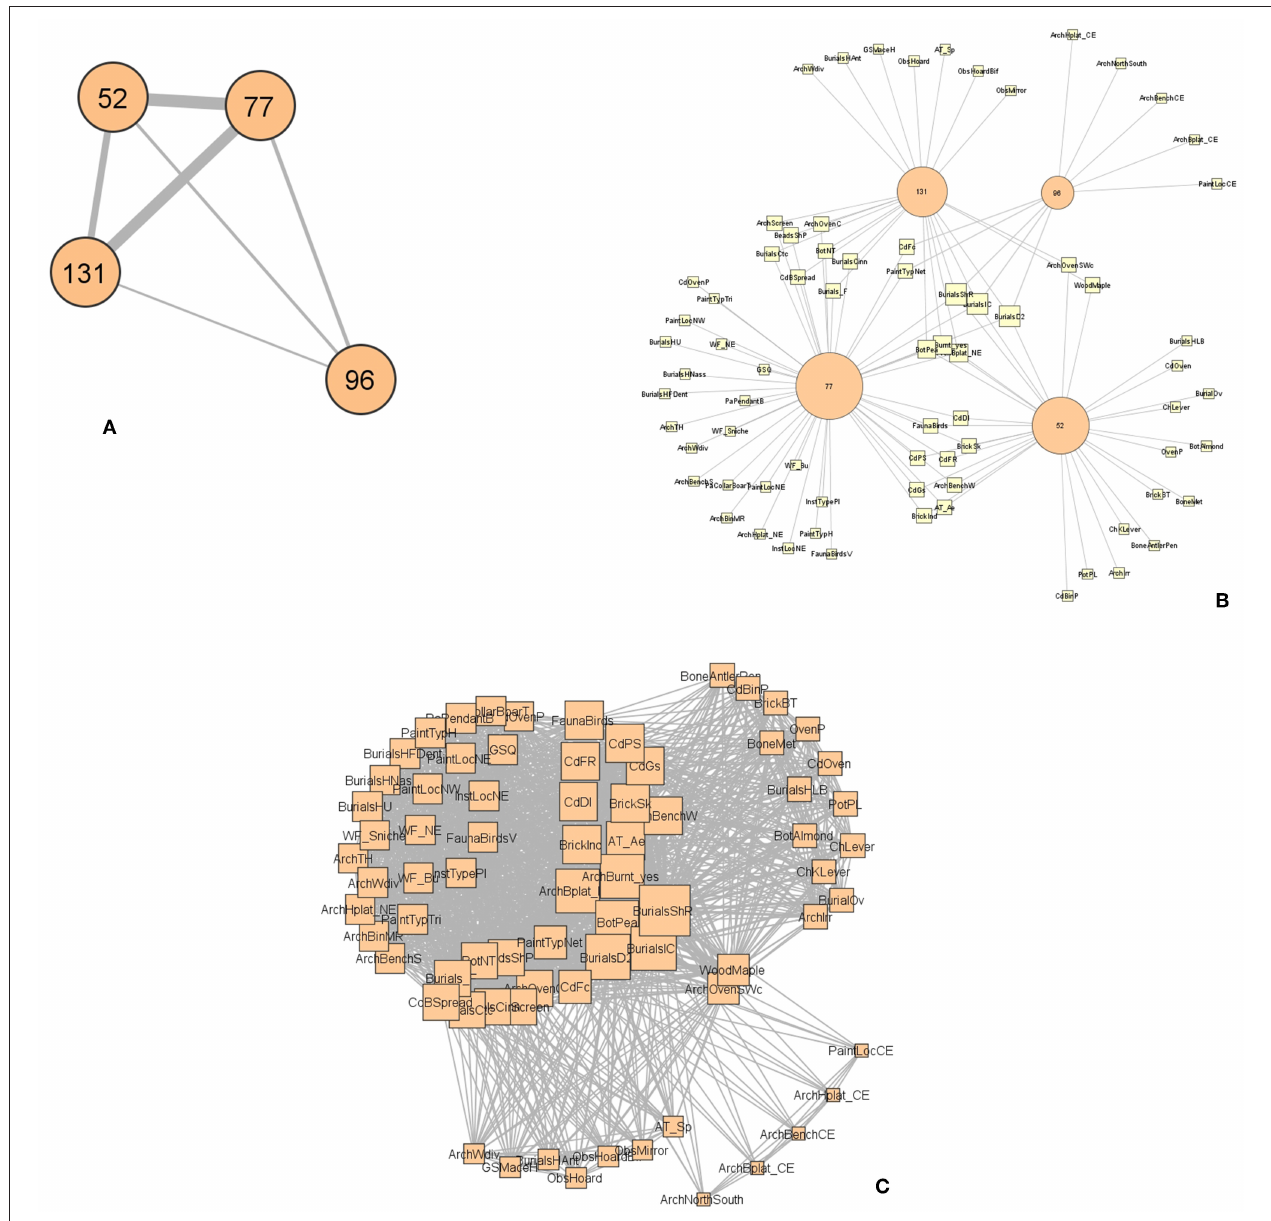
FIGURE 9 | Middle network orange module (A) . 2-mode network ( B size of nodes according to degree centrality) and object network (C) (The codes used are in the Supplementary Material